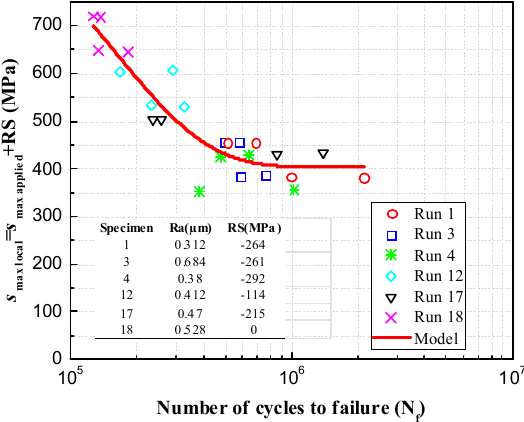
Figure 8. Residual stresses versus fatigue life: σ max local = σ max applied + RS.